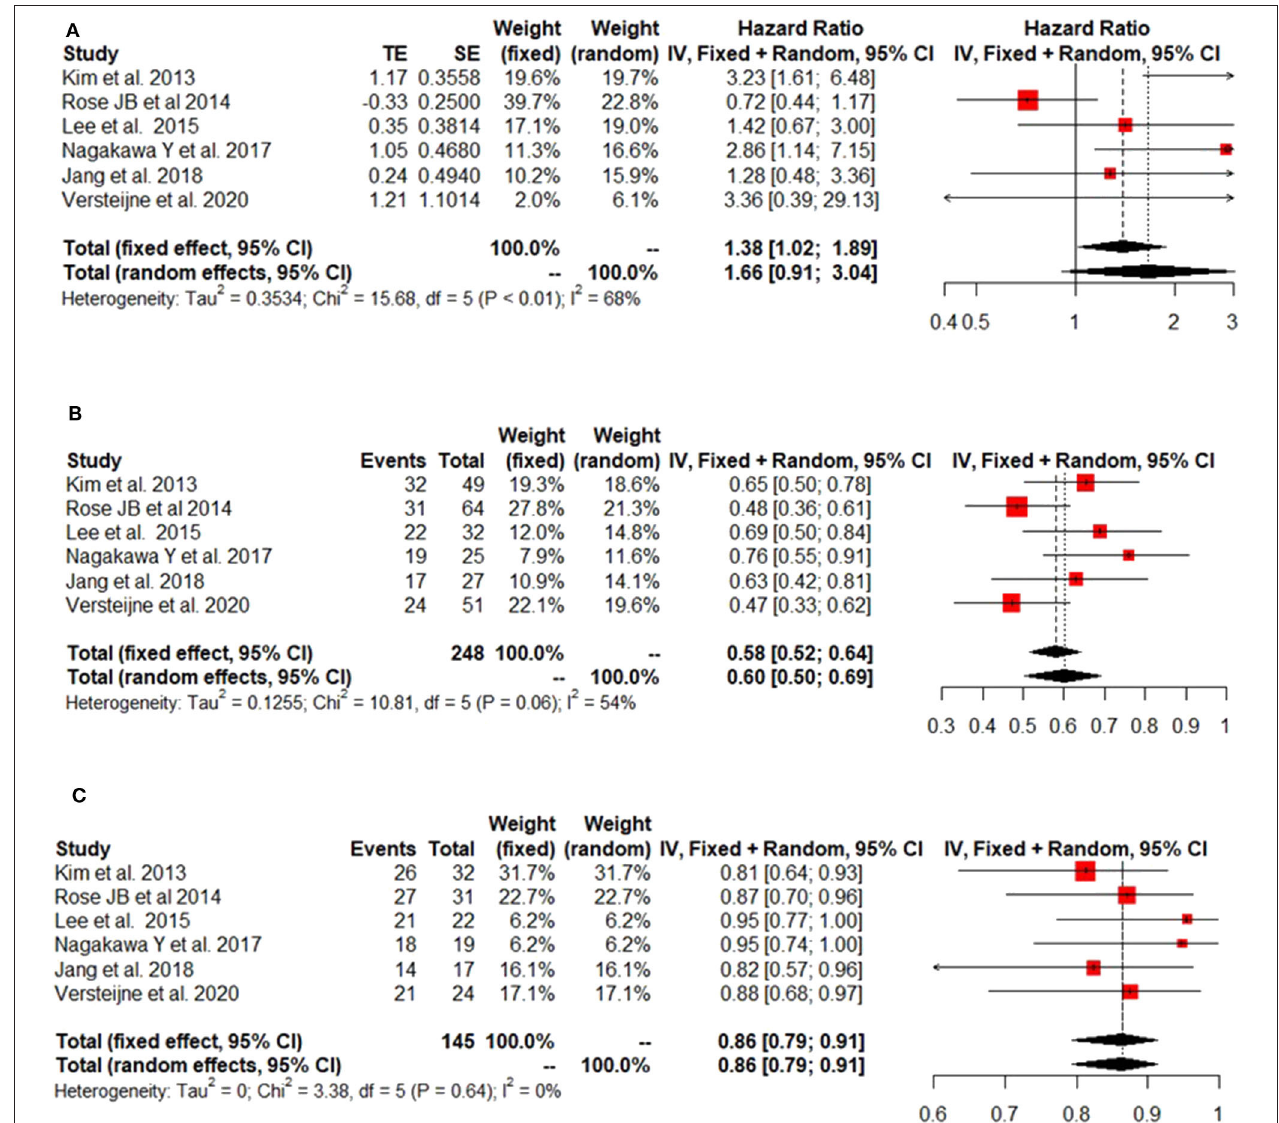
FIGURE 3 | Forest plots showing HR of survival (A) , rates of Resection Rate (B) and RO (C)